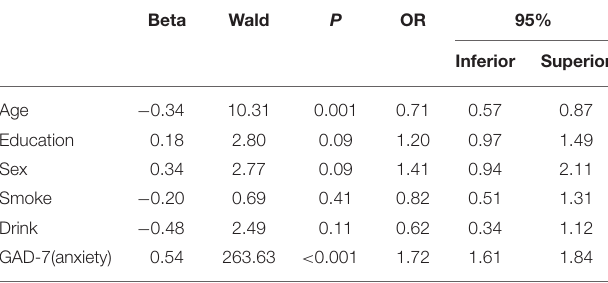
TABLE 7 | Influencing factors of depression in Nurse FL.